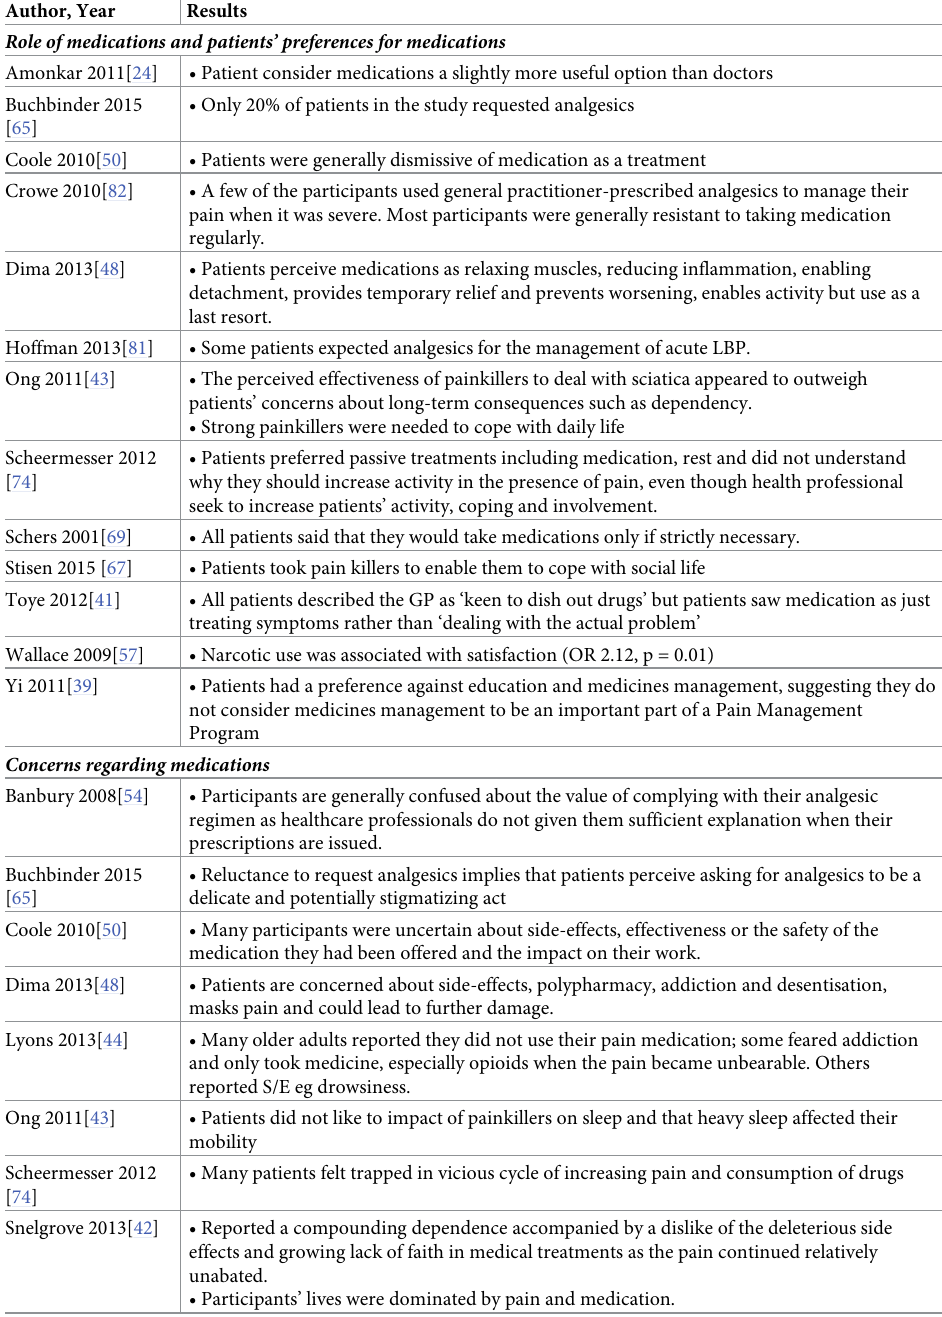
Table 3. The perceived need for pharmacological